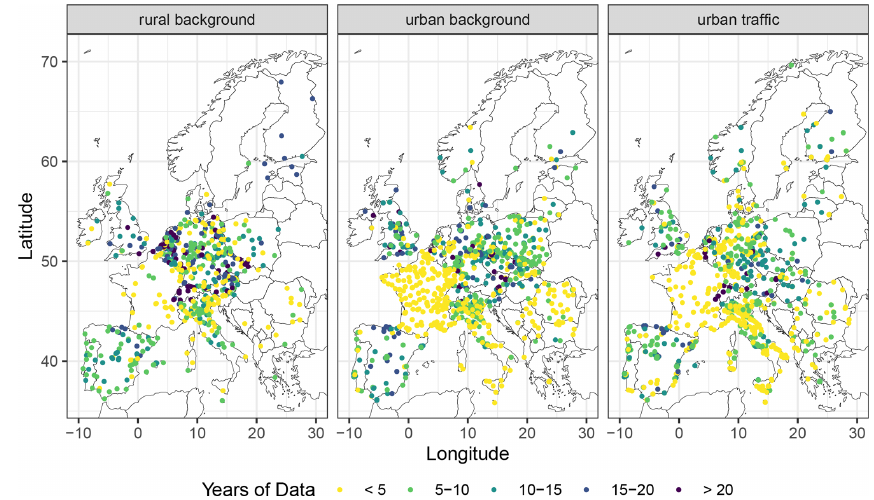
Figure 1. Air quality monitoring stations from which NO x data are available through the AirBase database, coloured depending on the number of years that the provided records span. The stations are classified based on their locations as rural background, urban background, or urban traffic sites. Table 1. Distance ranges within which rural background (RB) stations were considered to show consistent ranges, the outliers that were removed, and the final number of selected sites. “–” denotes that no lower limit was set or no outliers were removed. City Lower limit Upper limit Removed outliers No. of sites [km] [km] Augsburg – 124 one value > 30µgm − 3 6 Berlin 25 154 – 11 Geneva – 80 London 190 one value > 50µgm − 3 100 station CZ0UVSE; one value > 35µgm − 3 75 Zurich – 125